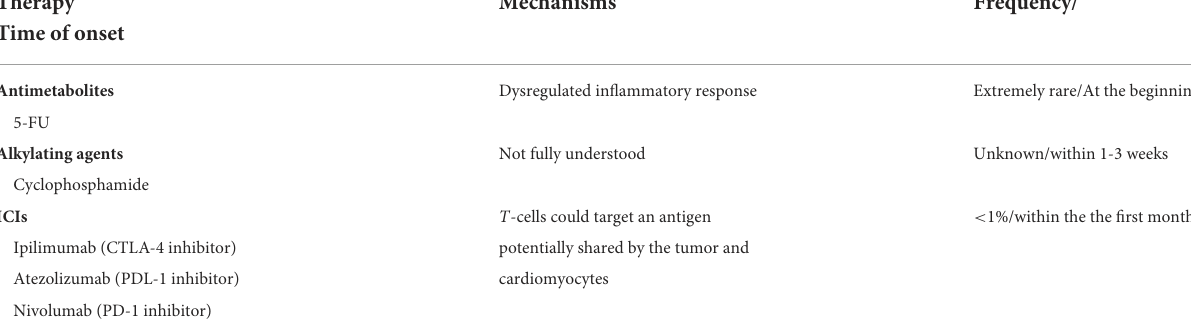
TABLE 3 Main cancer therapies that can induce myocarditis in cancer patients.